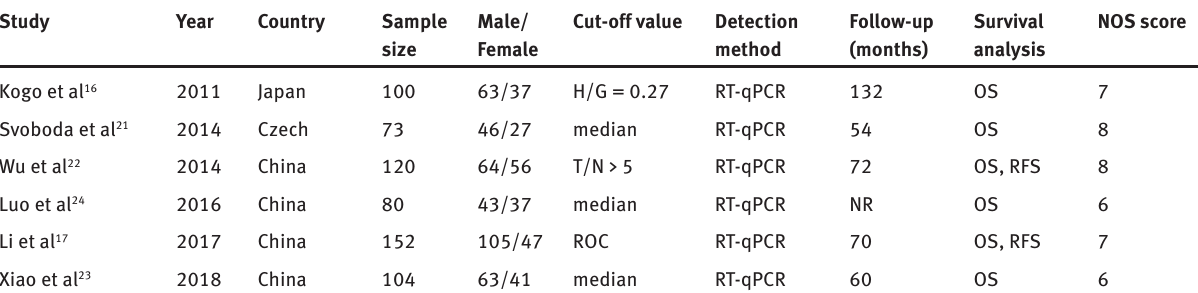
Table 1: Characteristics of included studies. Study